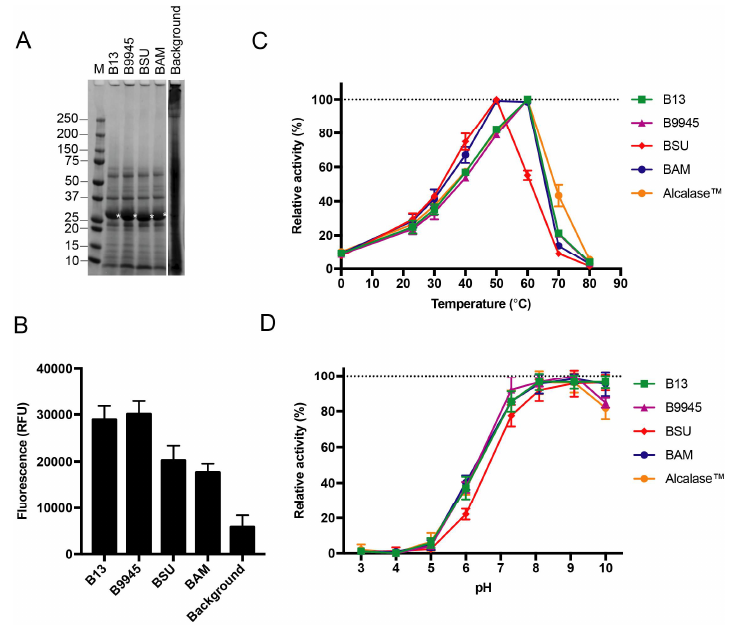
Figure 4. Four different subtilisin proteins expressed from FX-compatible Bacillus vectors. ( A ) A representative SDS-PAGE showing the supernatant fraction of the B. subtilis WB800N host after recombinant expression of native subtilisins from B. licheniformis DSM13 (B13), B. paralicheniformis ATCC 9945A (B9945), B. subtilis subsp. subtilis str. 168 (BSU) and B. amyloliquefaciens (BAM). Asterisks indicate recombinant enzymes (matured subtilisins expected mass is 28 kDa). Background represents expression of the empty vector; ( B ) Supernatants in A were screened for proteolytic activity against BODIPY-conjugated casein. Error bars show deviation in three biological replicates; ( C ) Temperature activity profiles of recombinant subtilisins (B13, green; B9945, magenta; BSU, red; BAM, blue) screened for proteolytic activity against the chromogenic succinyl-AAPA peptide, and compared to commercial Alcalase™ 2.4L (orange). Error bars show deviation in three biological replicates; ( D ) pH activity profiles of recombinant subtilisins screened against the peptide in C. Error bars show deviation in three biological replicates.